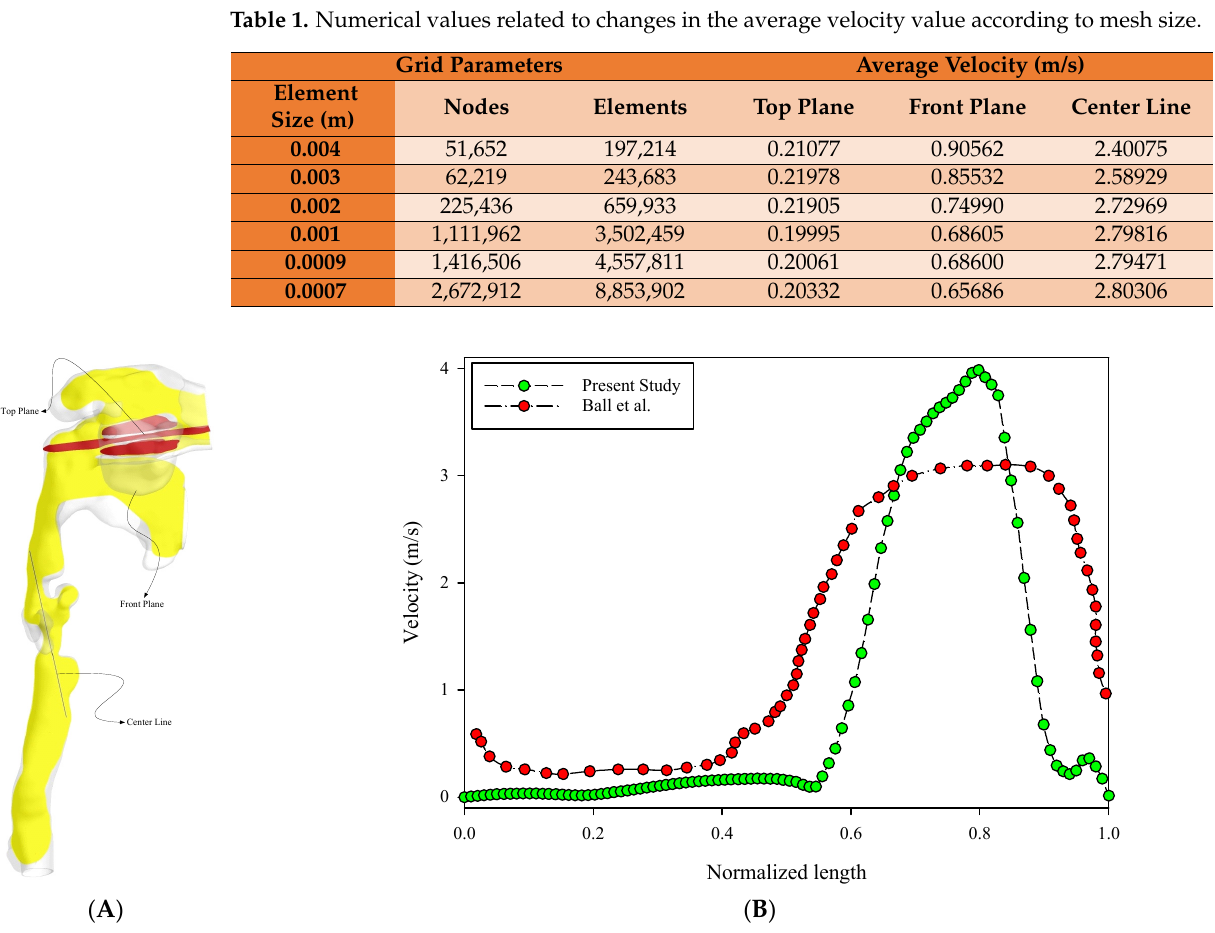
Figure 2. Upper respiratory tract view and validation. ( A ) The top plane (red), front plane (yellow), and center line are defined in the 3D model. ( B ) Verification of the present research with the study of Ball et al. [1] for the trachea velocity profile entrance. Table 1. Numerical values related to changes in the average velocity value according to mesh size.